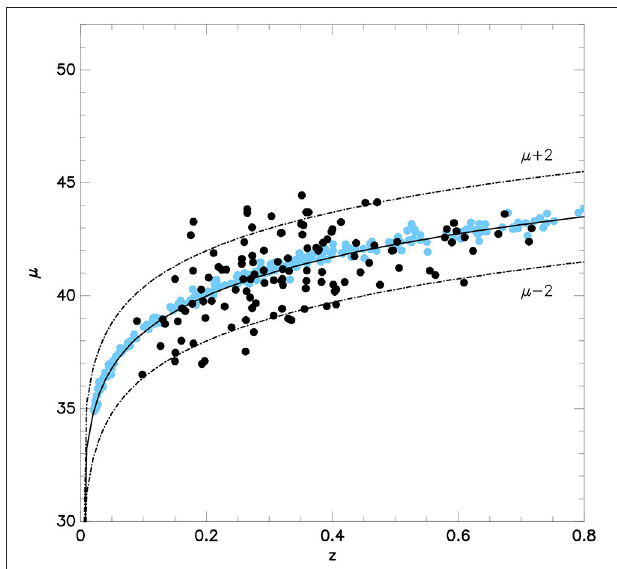
FIGURE 2 | Distance modulus of the “extreme sample” (black dots) and the Kessler et al. (2009) SDSS-II SN sample (cyan dots) with respect to the redshift. Solid curve is the expected distance modulus for the concordance cosmology, dash dotted lines are the distance modulus with a difference of ± 2 in magnitude with respect to the solid